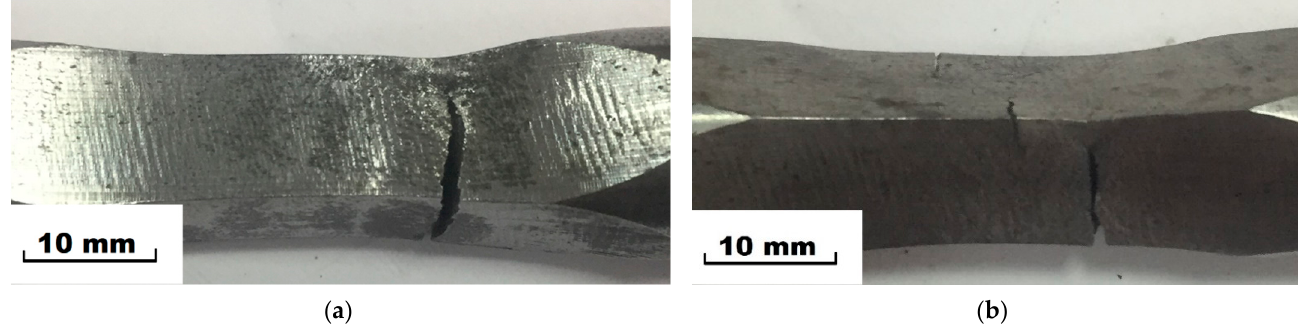
Figure 4. Specimens after fatigue tests, ( a ) initial condition, ( b ) after LSP.